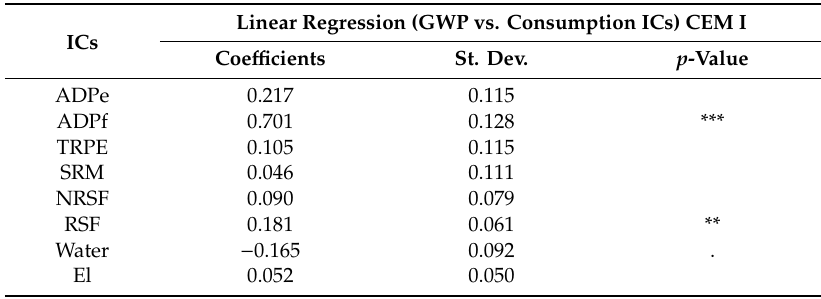
Table 9. Linear regression summary (GWP vs. Consumption ICs)—CEM I.